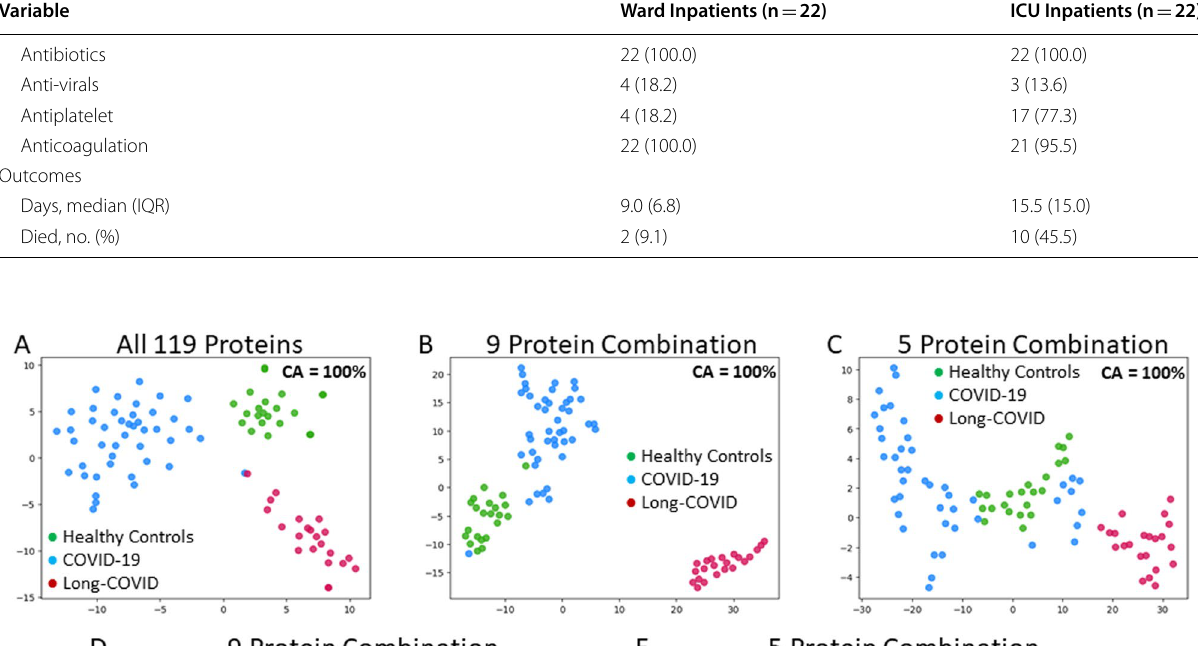
a distinct separation between the Long-COVID out- patients and the acutely ill COVID-19 inpatients and healthy control subjects (Fig. 1C; classification accuracy